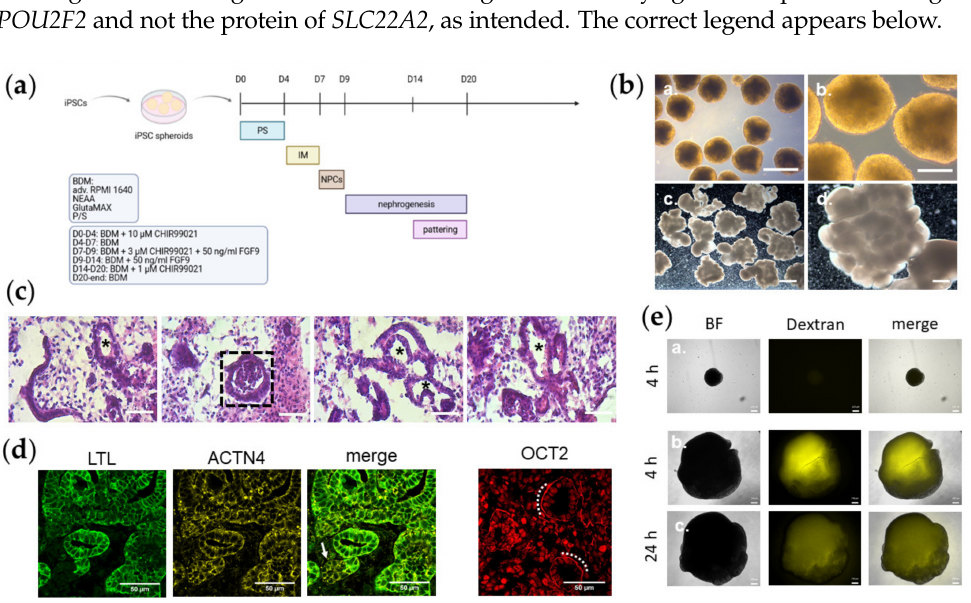
Figure 1. Lobular kidney organoids contain distinct kidney structures. ( a ) Schematic depiction of the protocol for generating kidney organoids. ( b ) Overview of iPSC spheroids at D8 after generation (a.,b.) and kidney organoids UMK2 at D21 (c.,d.) with binocular. (a.) 4 × magnification under light microscope. Scale bar depicts 500 µ m. (b.) 10 × magnification under light microscope. Scale bar depicts 200 µ m. (c.) 1 × magnification. Scale bar depicts 2000 µ m. (d.) 4 × magnification. Scale bar depicts 2000 µ m. ( c ) Morphology of organoid section via histological H&E staining. A typical glomerulus-like structure is depicted by a dashed rectangle. Tubule-like structures are marked with an asterisk. Scale bar depicts 50 µ m. ( d ) Confocal pictures of glomerular (ACTN4, yellow) and tubular (LTL, green) structures in UMK1 sections. Nuclear OCT2 ( POU2F2 ) (red) is expressed in UMK1 sections. A glomerulus-like structure was marked with an arrow. Scale bar depicts 50 µ m. ( e ) Monitoring of iPSC spheroids and kidney organoids in a dextran uptake assay. (a.) iPSC